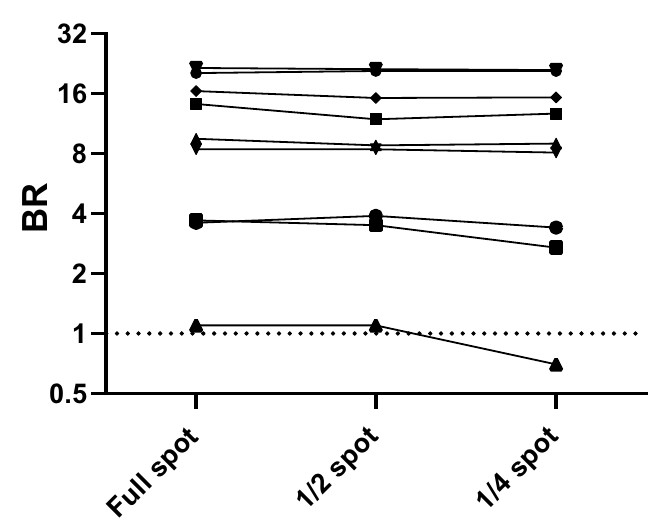
Figure 3. Analytical stability of DBS on IgG S1 capture assay. Eluates from eleven sero-positive DBS were serially diluted two-fold in elution buffer and the BRs determined on the IgG S1 capture assay. Each line with data points represents a different individual. The arrow indicates the highest dilution at which reactivity is maintained. The dotted line represents the assay cut-off.